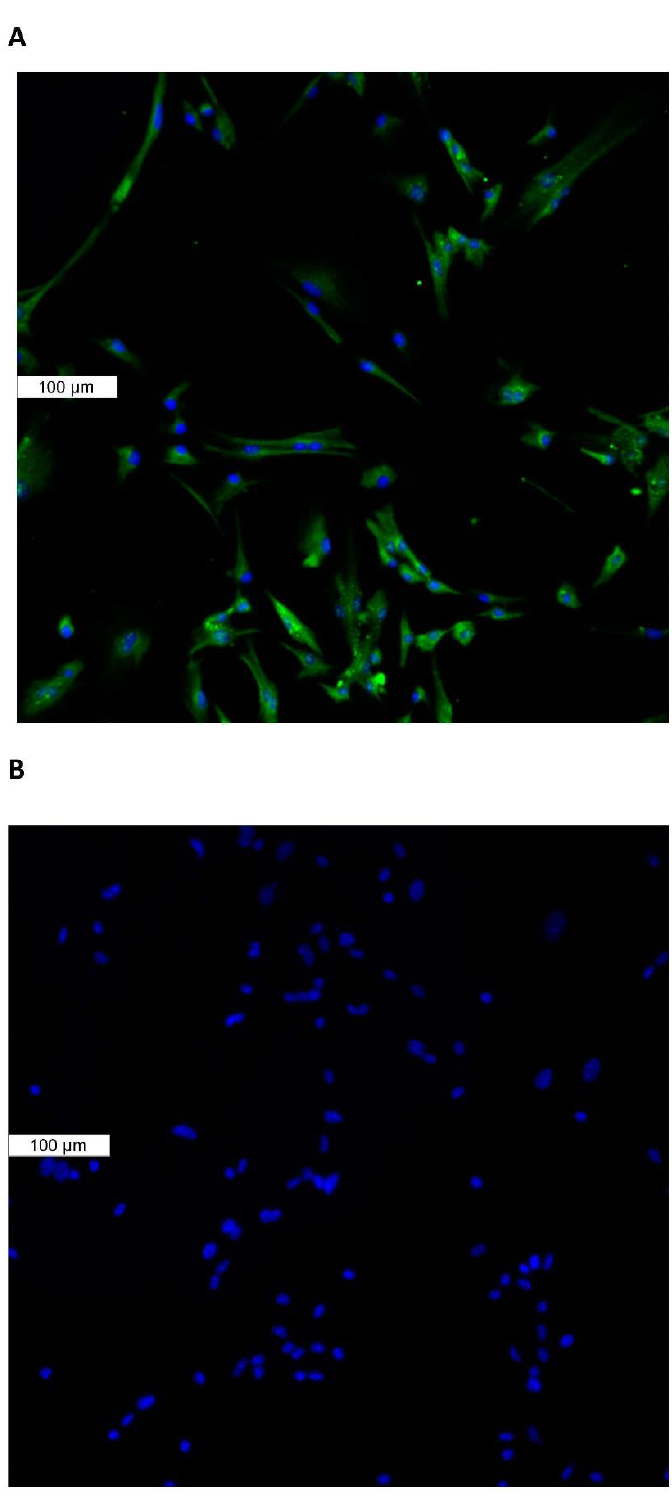
Figure 1. Immunolocalization of piezo1 in mouse lens. ( Panel A ) shows piezo1 (green) and nuclei (blue) in the epithelial cell monolayer, which covers the anterior surface of the lens. The image shows the equatorial region of the lens, where nuclei are evident in the differentiating fiber cells of the outer lens cortex. ( Panel B ) shows the negative control, in which no primary antibody was used. ( Panel C ) shows a section of the eye, stained with Hematoxylin and Eosin, that shows the lens with respect to the iris, ciliary body, retina, and cornea. The epithelial cell layer, which plays a critical role in ion transport, is positioned at the anterior lens surface, but not at the posterior surface.